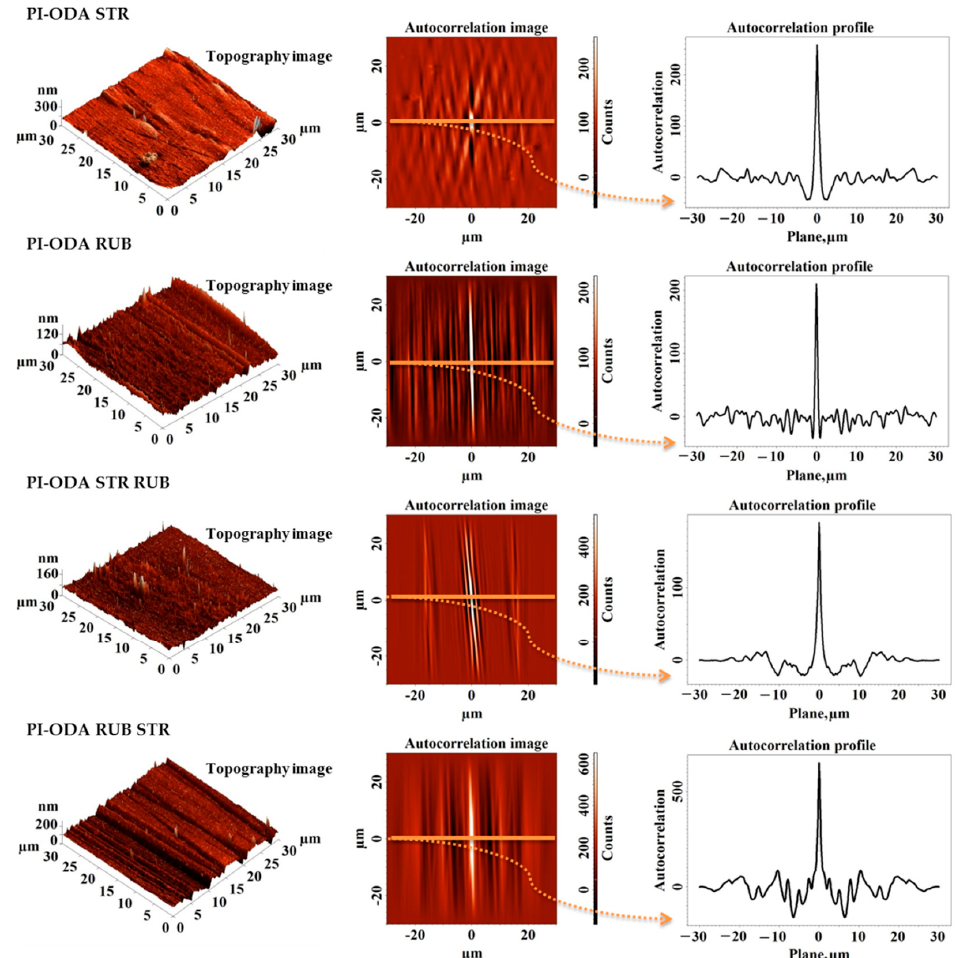
Figure 7. Topography and corresponding autocorrelation images obtained for polyimides PI-ODA after stretching (STR), rubbing (RUB), rubbing after stretching (STR RUB), and stretching after rubbing (RUB STR).